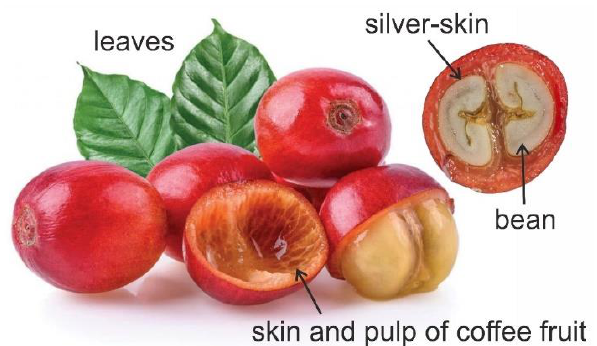
Figure 3. Coffee fruit anatomy.